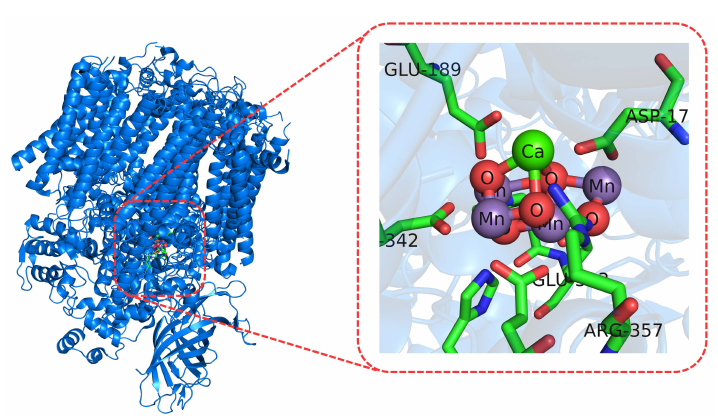
Figure 6. Active site ( right ) of the oxygen-evolving complex in PSII ( left ).